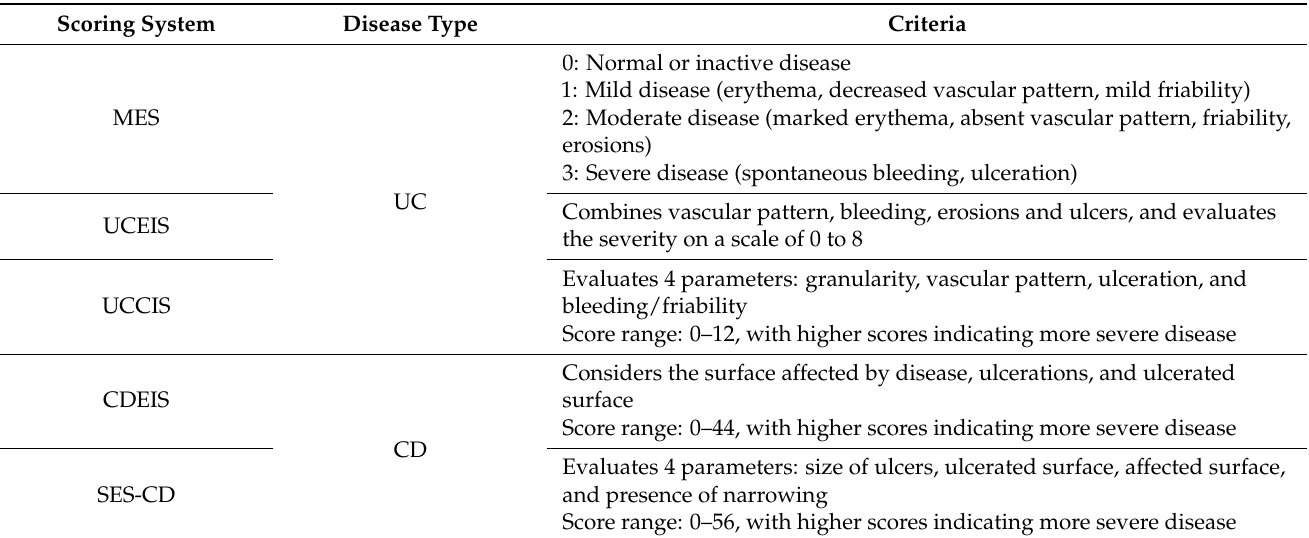
Table 2. Endoscopic scoring systems for